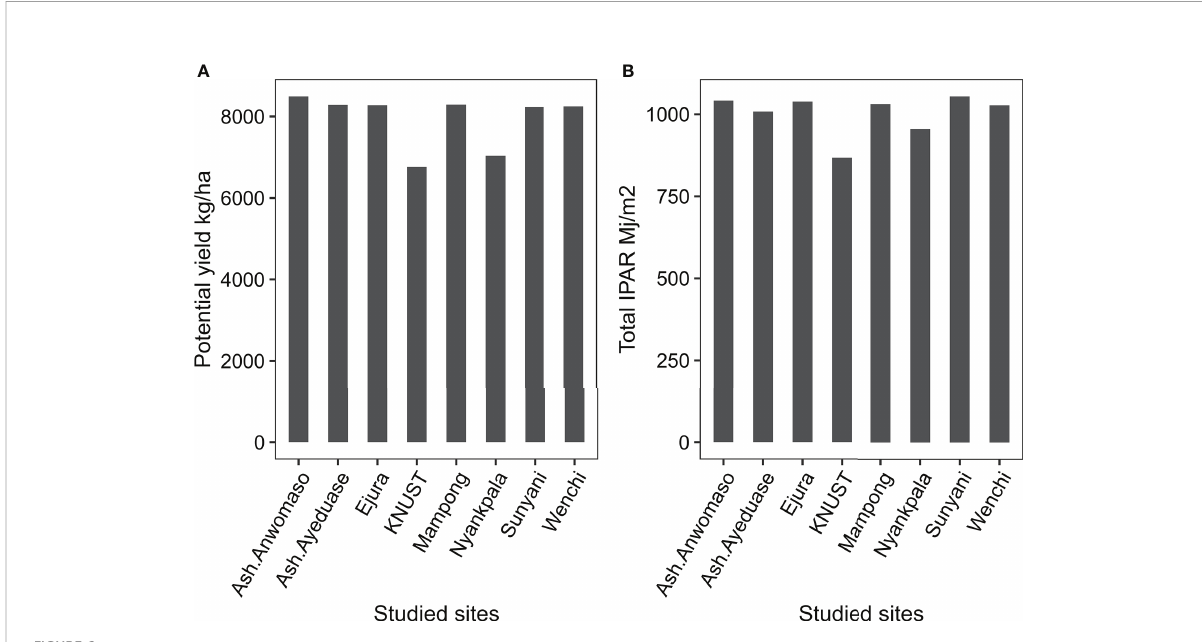
FIGURE 6 (A) Simulated yield potential of maize by LINTUL-1 and (B) total intercepted photosynthetic active